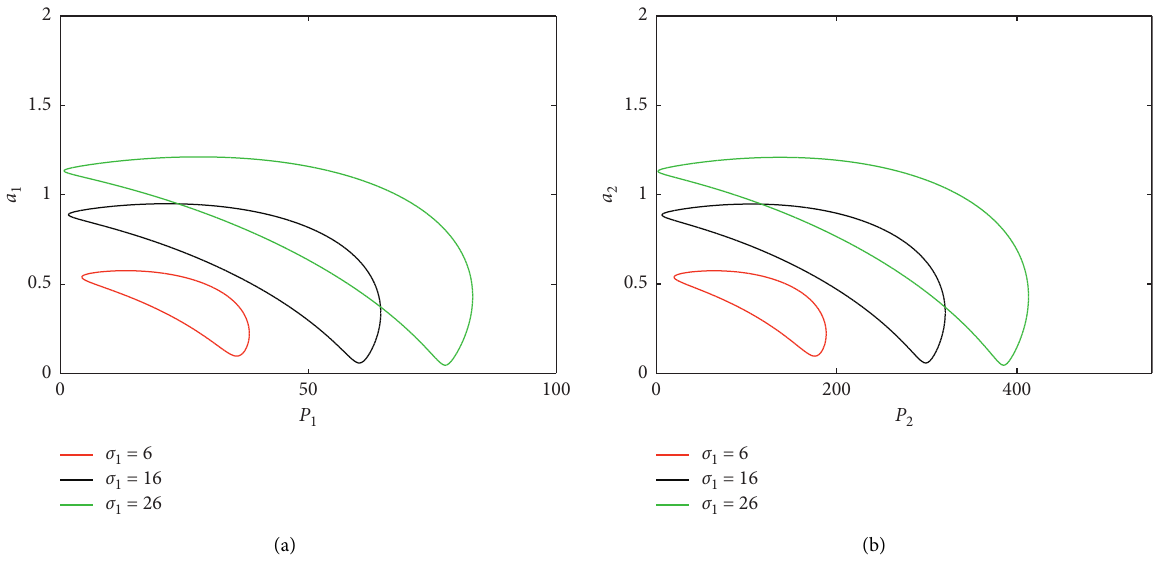
Figure 4: Force-amplitude response curves of the first-order and second-order mode for different excitation frequencies.